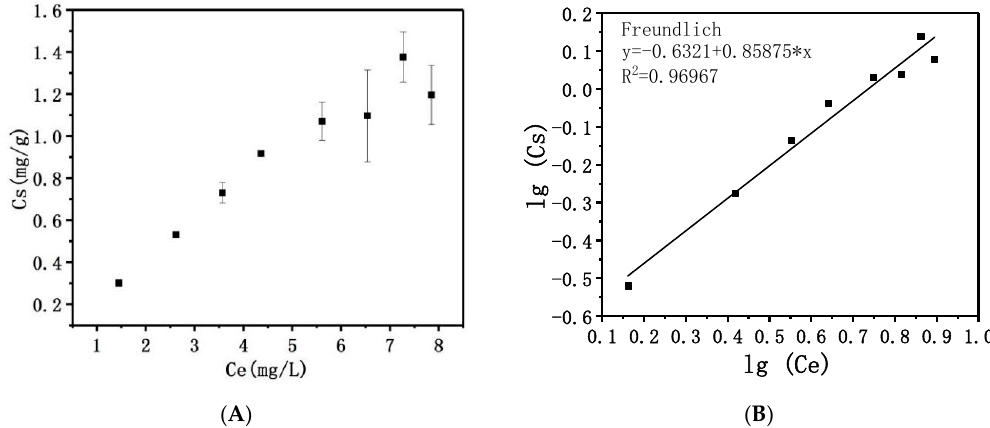
Figure 2. Adsorption isotherm of dextranase onto Mg/Fe-LDH ( A ) and modeling according to Freundlich equation ( B ).